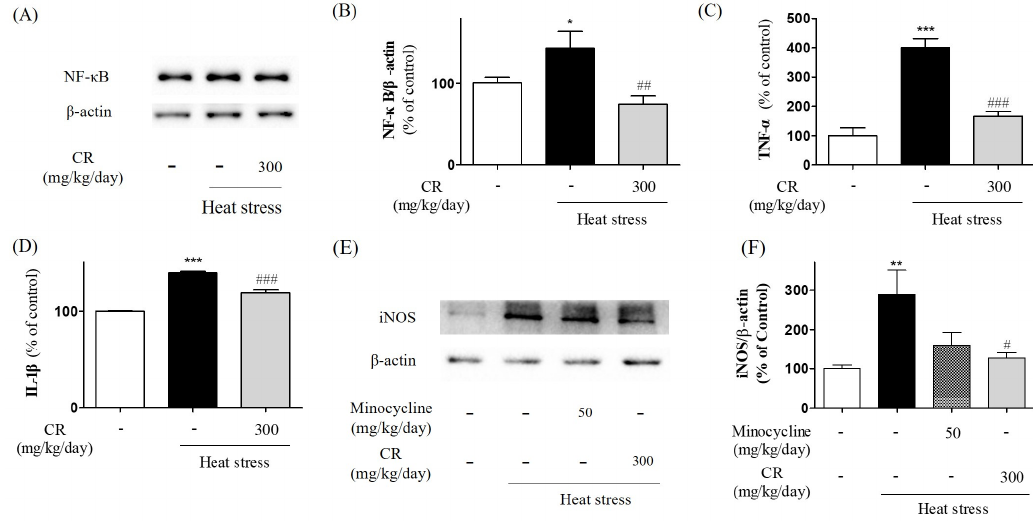
Figure 6. Effects of CR on thermal stress ‐ induced NF ‐κ B activation and up ‐ regulation of pro ‐ inflammatory mediators. ( A ) Representative Western blot analysis of the expression of NF ‐κ B